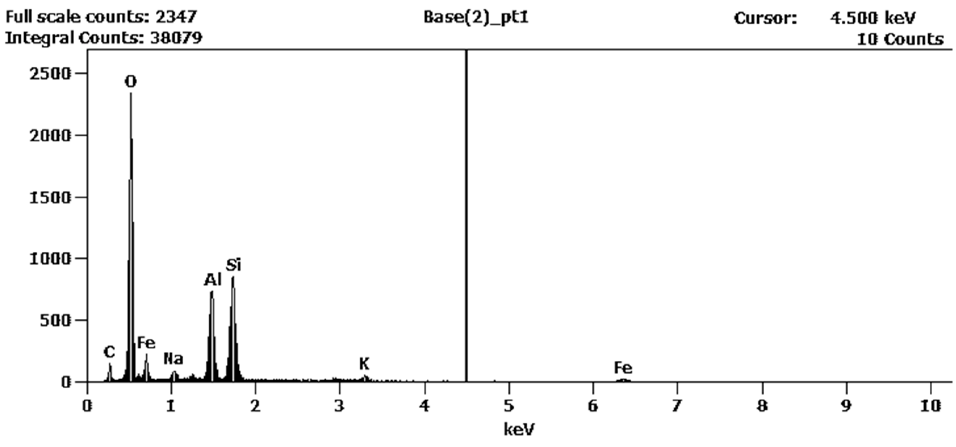
Figure 12. EDS spectrum of Point 1 according to Figure 11.